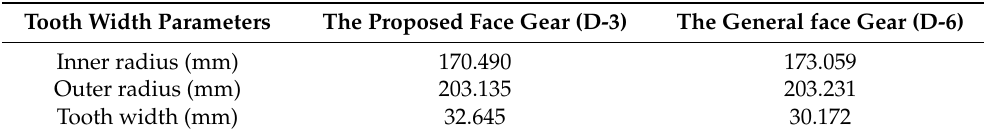
Table 3. Comparison of two face gears tooth